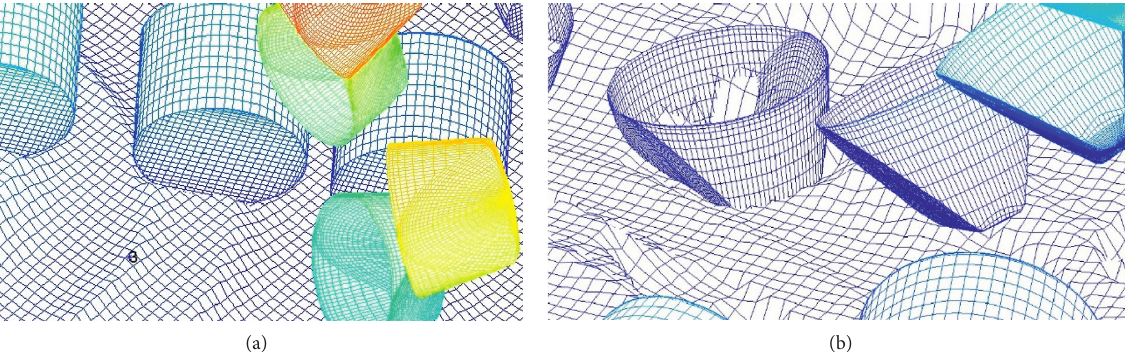
Figure 8: Digital simulation of combined bit teeth and PDC teeth in contact with the bottom. (a) Bottom contact state of PDC teeth. (b) Bottom contact state of tooth teeth.